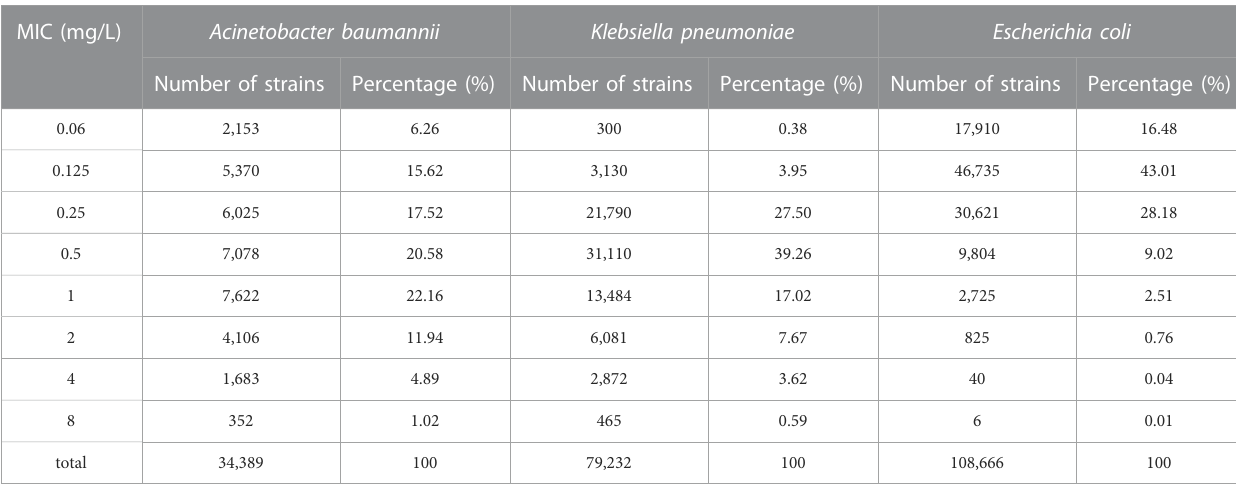
TABLE 3 MIC distribution of tigecycline about three